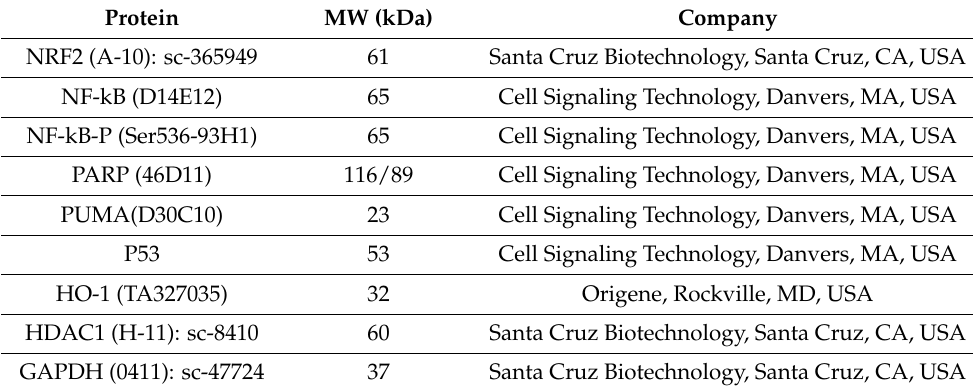
Table 3. List of primary antibodies